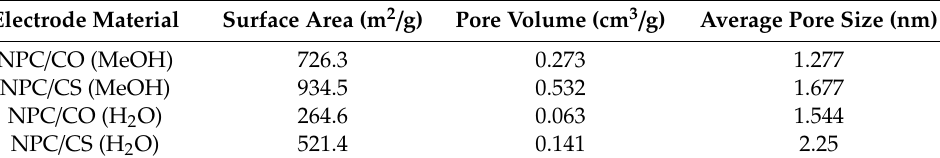
Table 2. Surface area, pore volume, and average pore size of NPC / CO and NPC / CS.